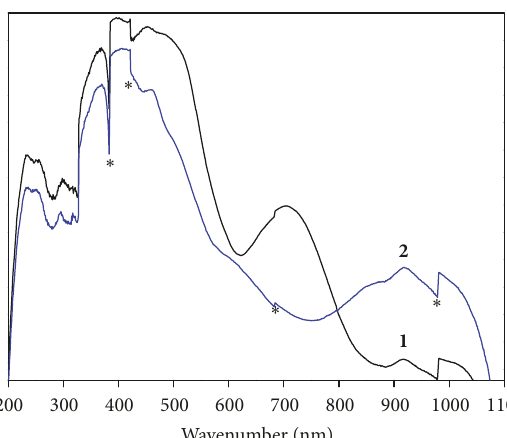
The S 2p band region shows a single broad peak in 162 eV, with a FWHM = 2.6 eV by the presence of the 2p 1/2 and 2p 3/2